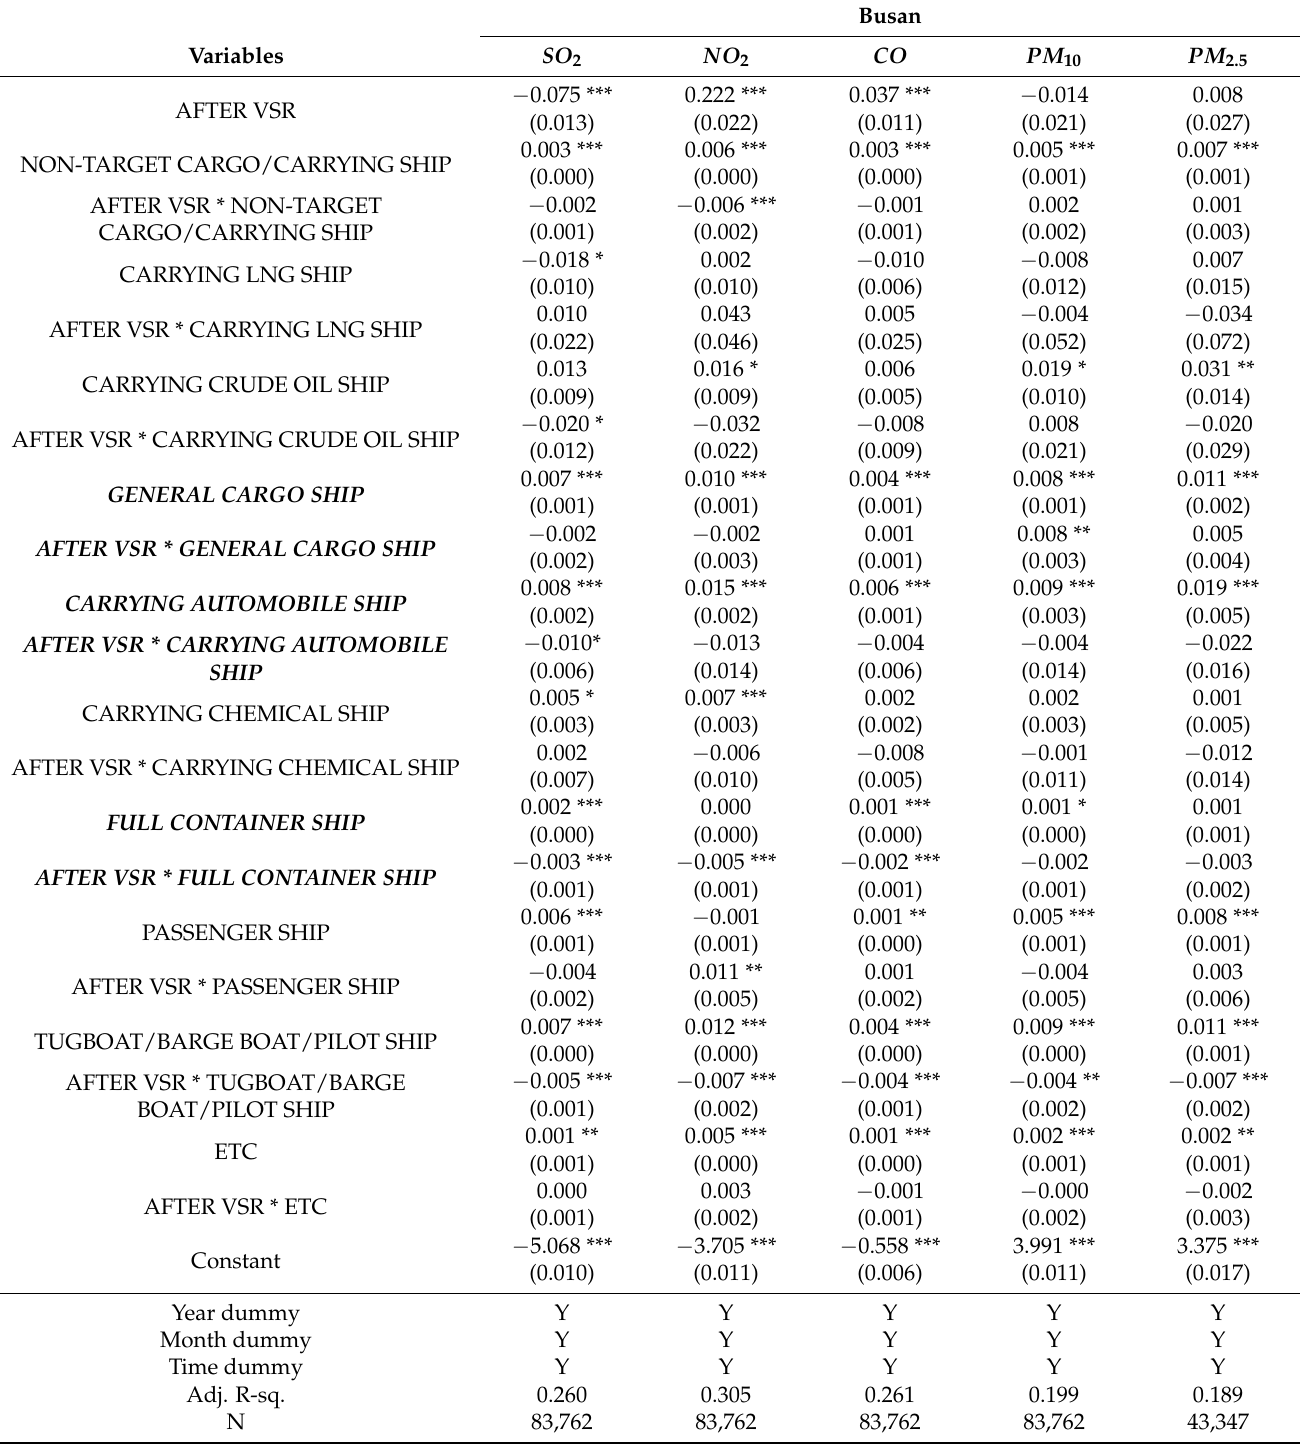
Table 4. Estimation results of Busan